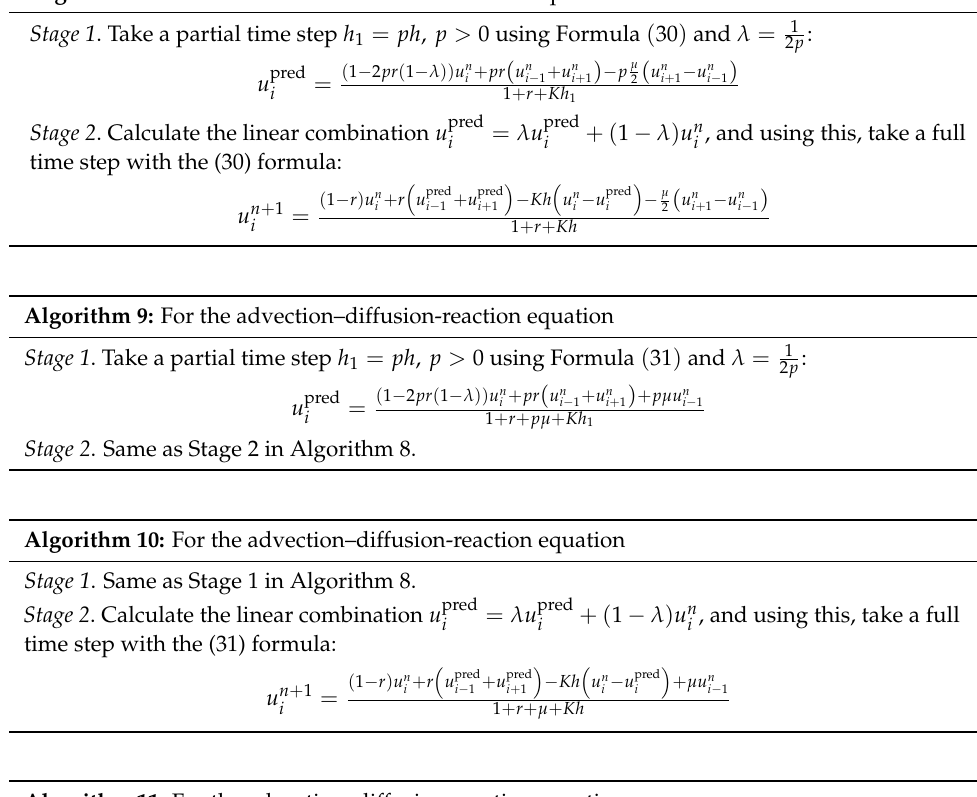
Algorithm 8: For the advection–diffusion-reaction equation